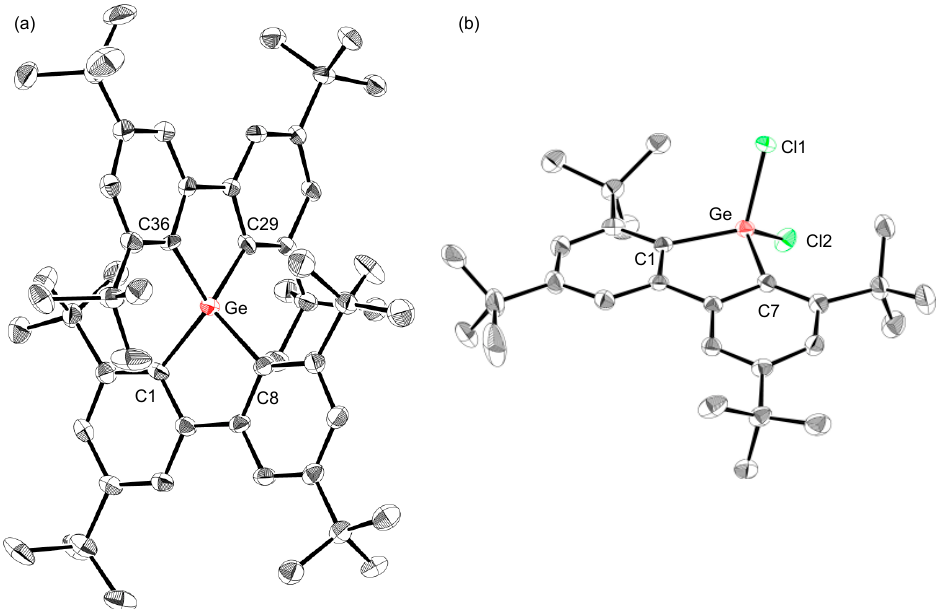
Figure 2. Molecular structures of ( a ) spirogermabifluorene 1 and ( b ) dichlorogermane 5 with thermal ellipsoids at 50% probability. Selected bond lengths (Å) and angles (°): (a) 1 , Ge–C1, 1.972(5),